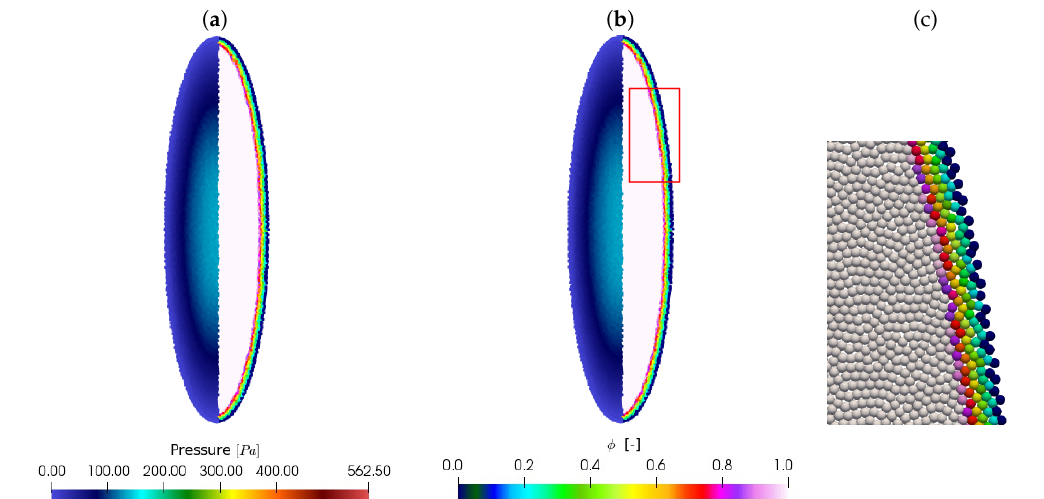
Figure 7. Oscillating droplet under a central conservative force field: The particle are colored with pressure and dimensionless φ - parameter on the left and the right half of the fluid droplet, respectively at the time t = 2.44 s. ( a ) under the resolution of dx = R The snapshot ( c ) shows a zoom on the φ field obtained through the selected red rectangle of the snapshot ( b